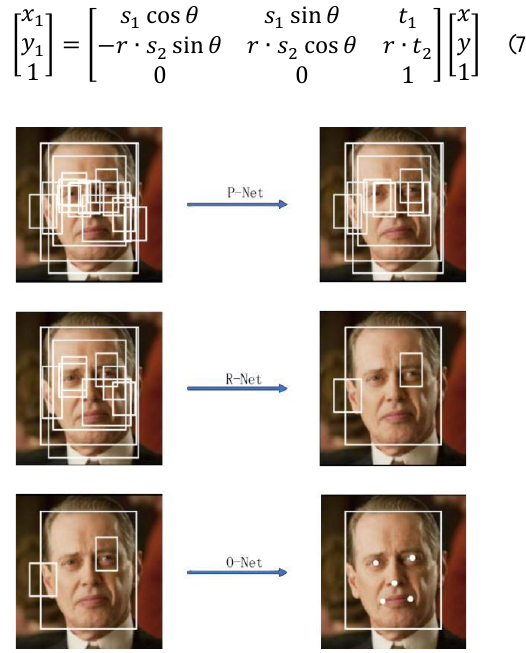
Figure 13. MTCNN detection effect